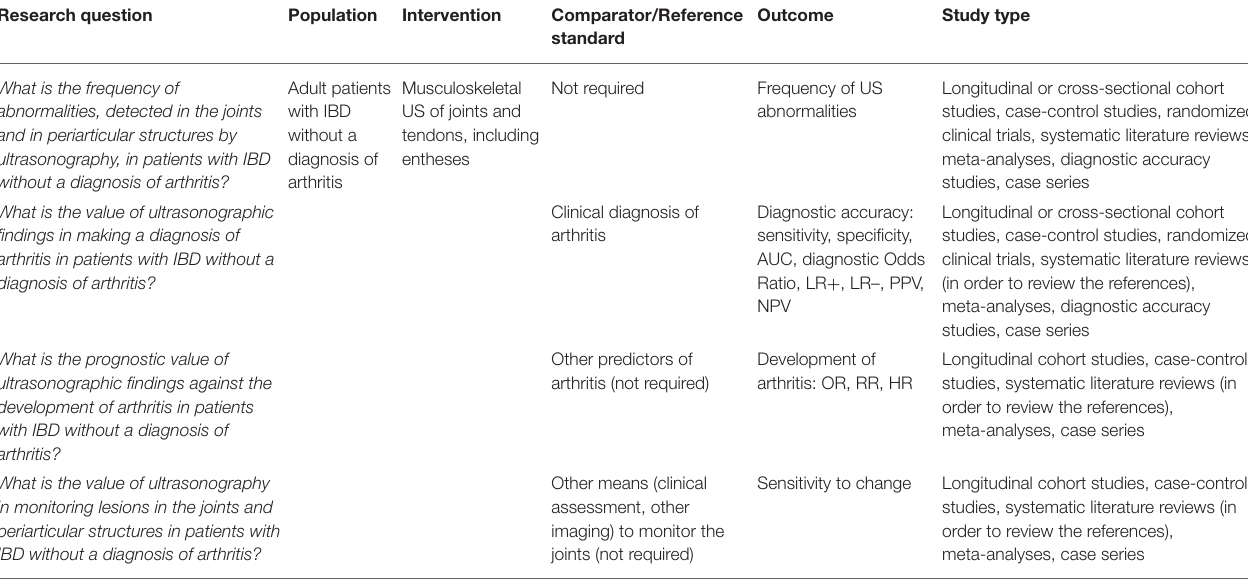
TABLE 1 | Research questions and corresponding PICOs, driving the literature search and the inclusion/exclusion of the articles. Population and Intervention are the same for all research questions.